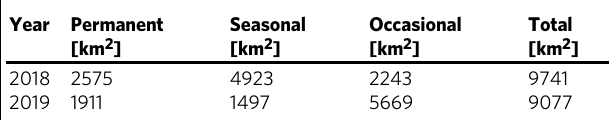
Table 1 Annual extent of the three main ecohydrological zones in the Okavango